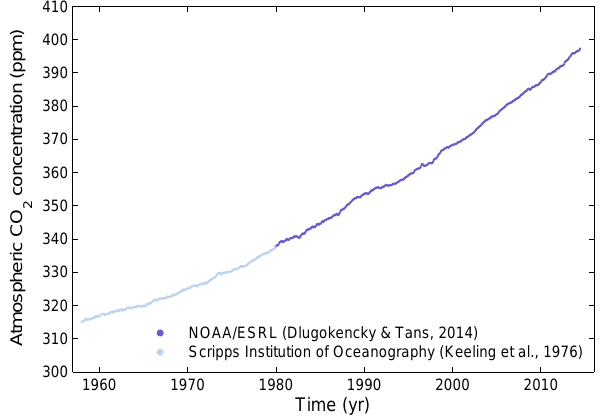
Figure 1. Surface average atmospheric CO 2 concentration, de- seasonalised (ppm). The 1980–2014 monthly data are from NOAA/ESRL (Dlugokencky and Tans, 2014). The 1980–2014 esti- mate is an average of direct atmospheric CO 2 measurements from multiple stations in the marine boundary layer (Masarie and Tans, 1995). The 1958–1979 monthly data are from the Scripps Institu- tion of Oceanography, based on an average of direct atmospheric CO 2 measurements from the Mauna Loa and South Pole stations (Keeling et al., 1976). To take into account the difference of mean CO 2 between the NOAA/ESRL and the Scripps station networks used here, the Scripps surface average (from two stations) was har- monised to match the NOAA/ESRL surface average (from multiple stations) by adding the mean difference of 0.542ppm, calculated here from overlapping data during 1980–2012. The mean seasonal cycle was removed from both data sets.